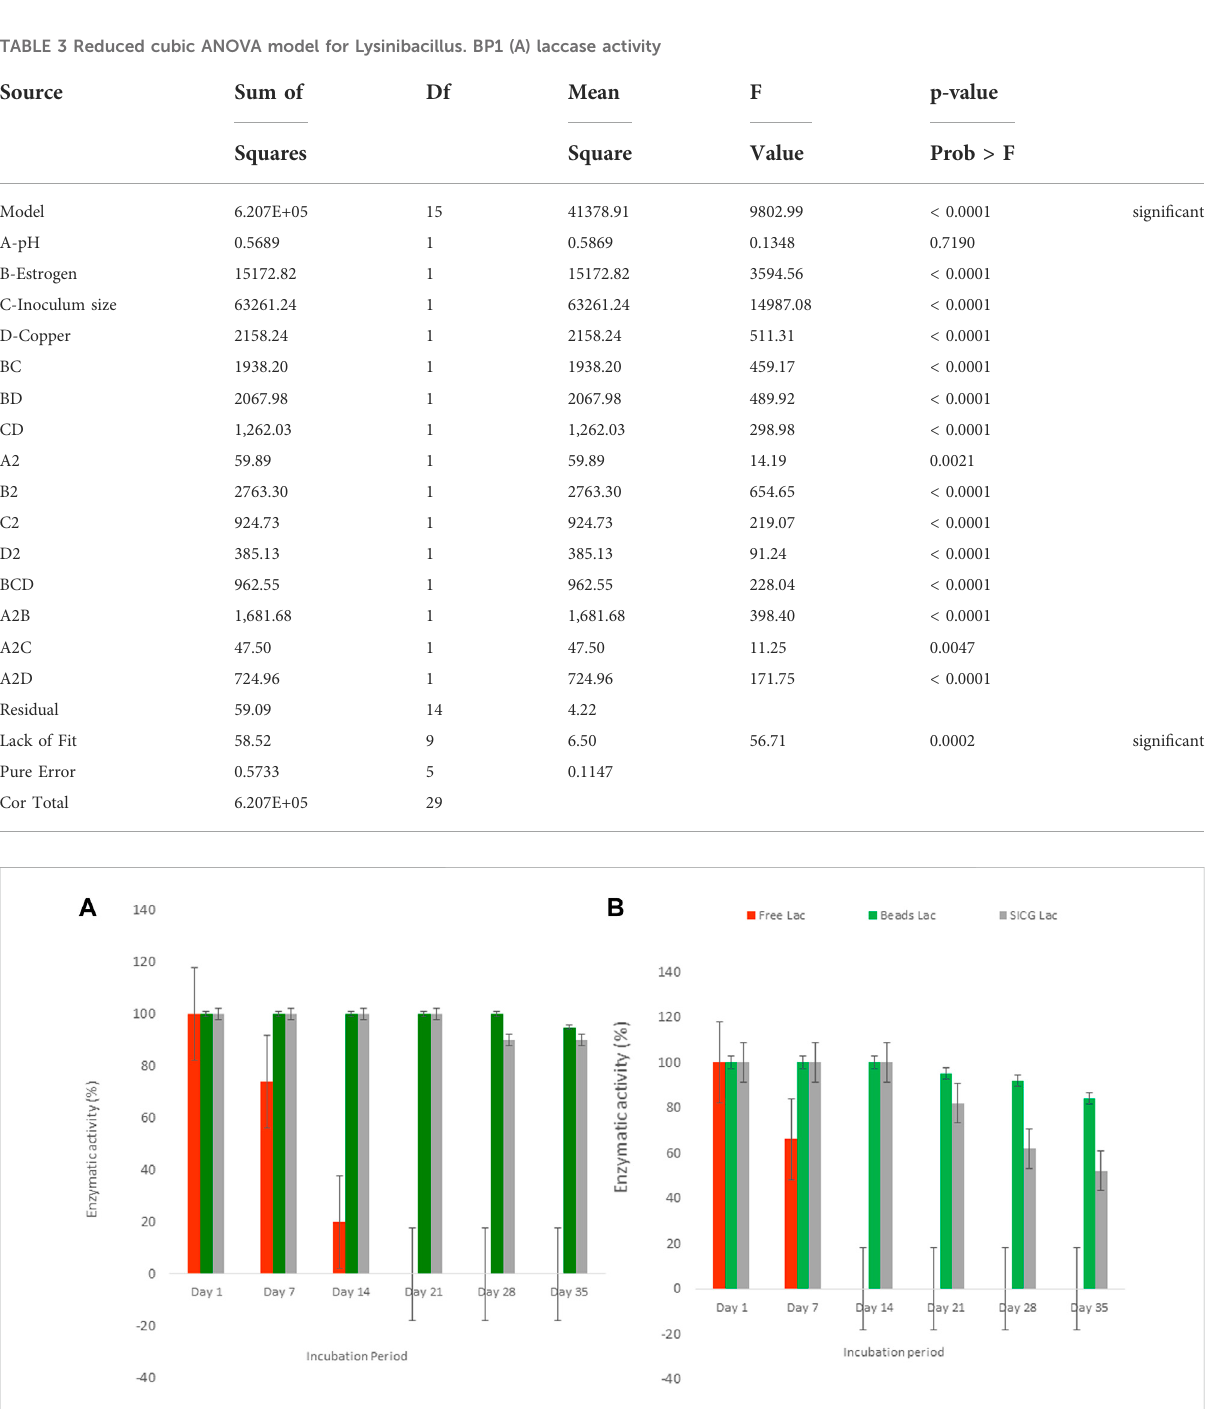
FIGURE 5 Storage stability of free and immobilized laccase at 25 (A) and 4 ° C (B)